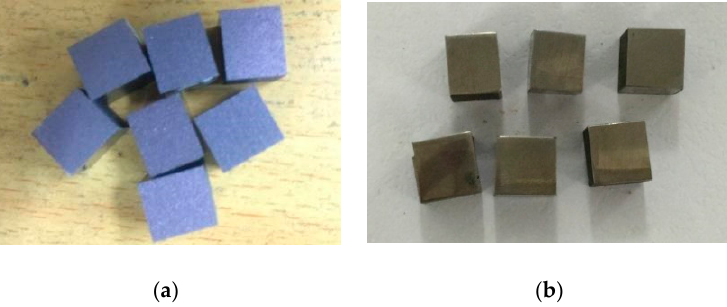
Figure 3. Titanium alloy samples. ( a ) Samples after wire cutting; ( b ) samples after grinding and polishing.